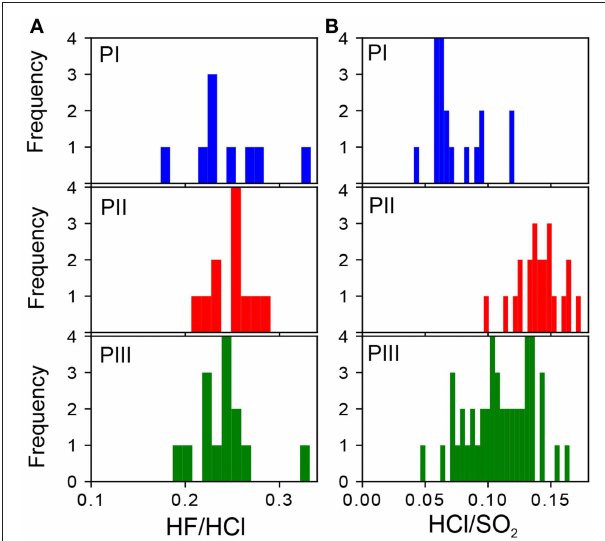
FIGURE 3 | Histogram of the (A) HF/HCl and (B) HCl/SO 2 ratios for each periods depicted in Figure 2 .